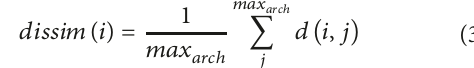
Figure 6: A stencil’s expression rendered to a single image, which is used to compute the similarity between stencils for the archive